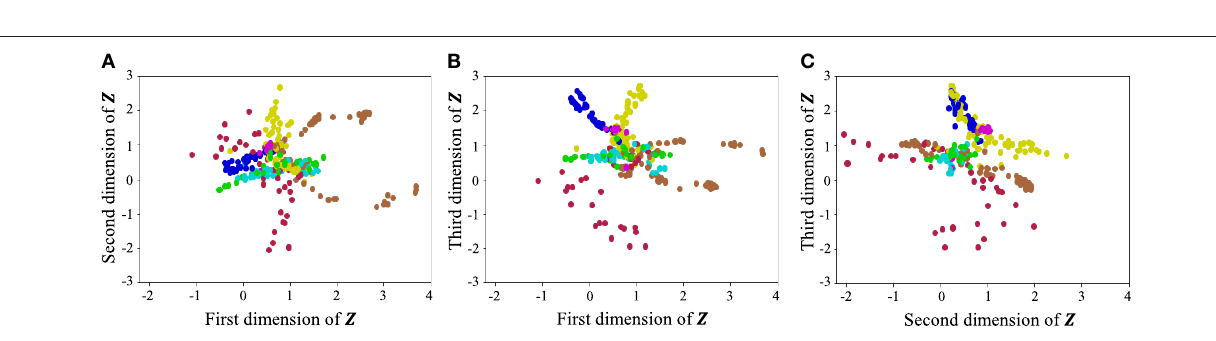
used identical to the latent variables of VAE. In the case of PCA and ICA, the min-max normalization, in which the values are normalized to a range from –1 to 1, was applied for the sequence of latent variables, as with Nagano et al.